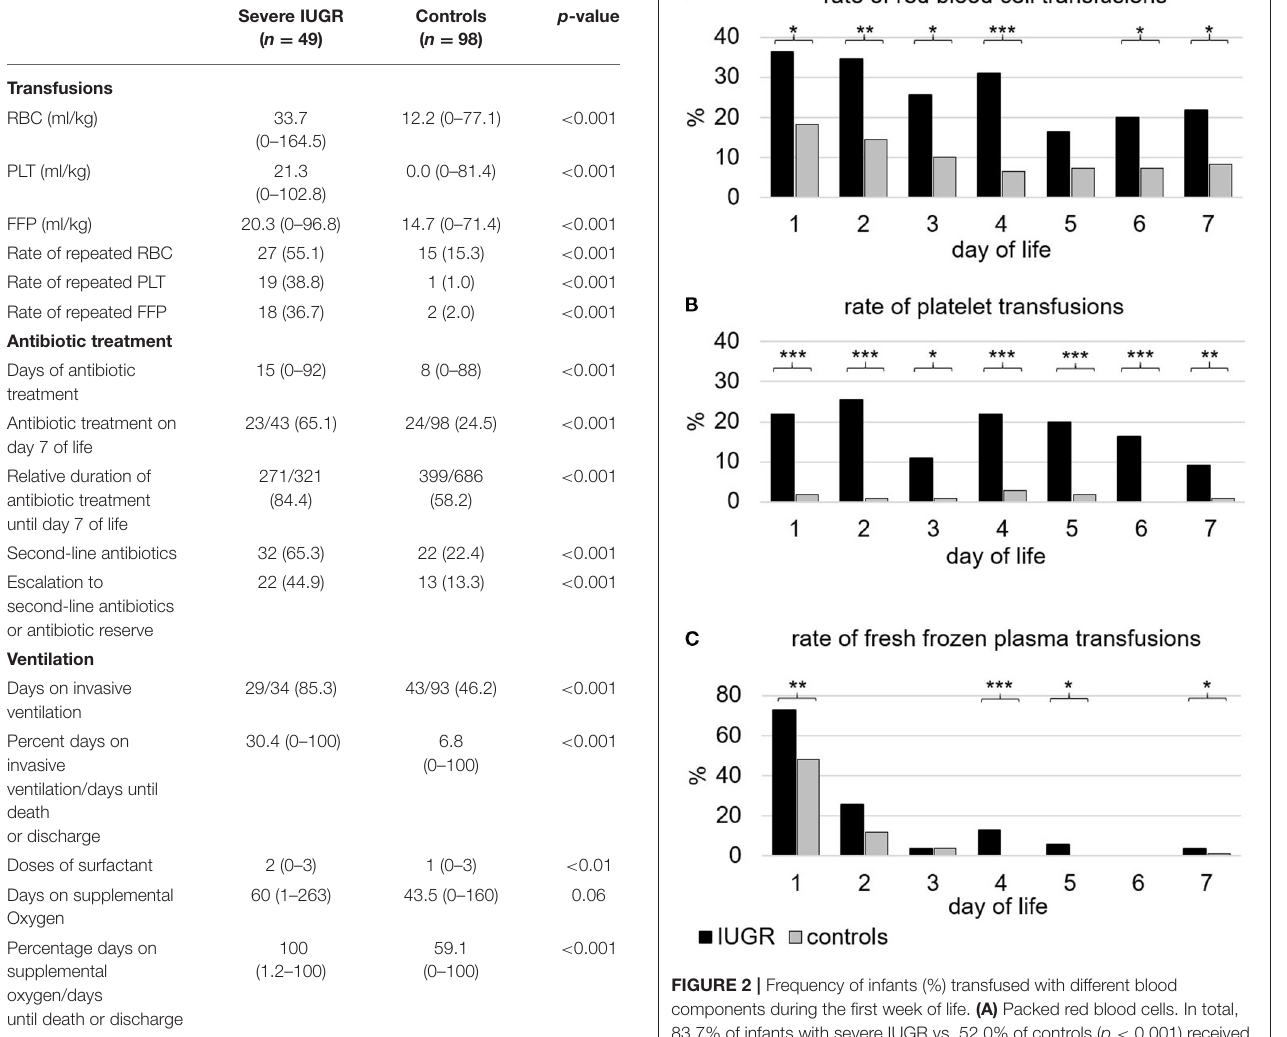
TABLE 4 | Treatment of ELGANs.